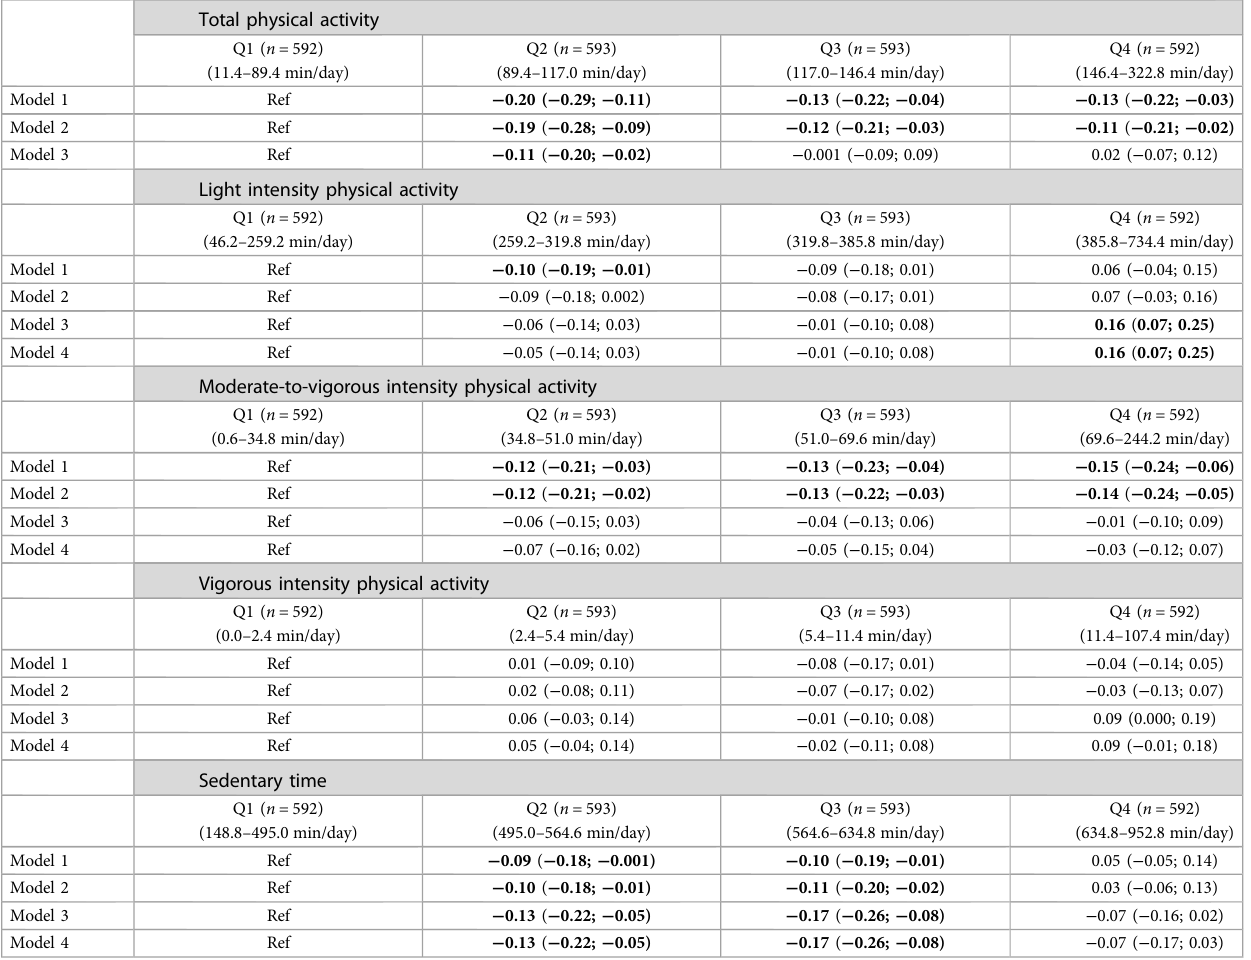
TABLE 3 Associations of physical activity (all intensities) and sedentary behavior with Hs-cTnT (categorical) ( n =2,370). Total physical